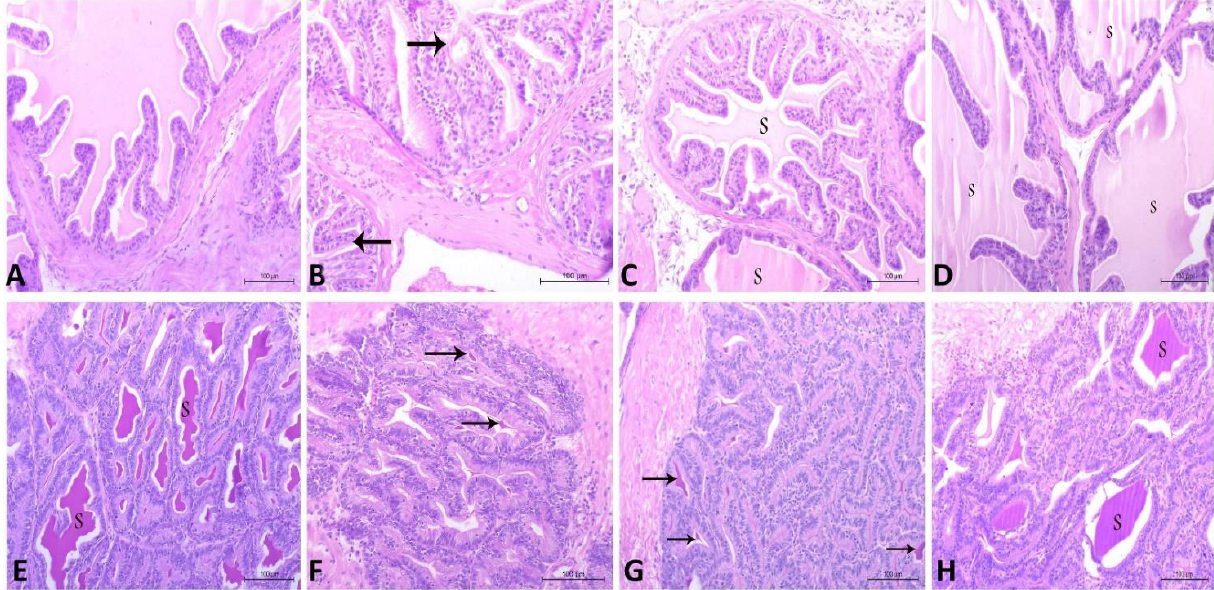
Figure 7. Histopathological characteristics of prostatic tissue ( A – D ) and vesicular gland ( E – H ) in adult male albino rats using hematoxylin and eosin (H and E) staining and magnification × 200. ( A ) Control group containing normal prostatic acini, lined with simple columnar secretory epithelium with secretory materials. ( B ) CdCl 2 group showing prostatic acini, which appear collapsed and inactive and are separated by thick connective tissue. The acini are lined with low columnar epithelium with low secretory activity. Note, few secretory materials appear in the lumen of the prostatic acini (arrow). ( C ) CdCl 2 and Vit. E group show less active prostatic acini lined with less active secretory cells and few amounts of secre- tory materials (S). ( D ) CdCl 2 and RCME group show normal prostatic acini lined with simple columnar secretory epithe- lium, with secretory materials (S). ( E ) Control group contains normal vesicular gland acini lined with high columnar epi- thelium, with huge amounts of secretory materials (S). ( F ) CdCl 2 group show vesicular gland acini appearing inactive and lined with low columnar epithelium, with few secretory materials (arrow). ( G ) CdCl 2 and Vit. E group show active vesic- ular gland acini lined with active secretory cells, containing few secretory materials (arrow). ( H ) CdCl 2 and RCME group show normal vesicular gland acini lined with simple columnar secretory epithelium and filled with secretory materials (S). Figure 8. Histopathological characteristics of prostatic tissue ( A – D ) and vesicular glands ( E – H ) in adult male albino rats using the periodic acid–Schiff (PAS) stain and magnification × 200. ( A ) Control group shows prostatic tissue with strong reaction in secretory epithelium and secretory materials (S). ( B ) CdCl 2 group shows very weak reaction in secretory epi- thelium and moderate reaction in secretory materials. Note, few secretory materials appear in the lumen of the prostatic